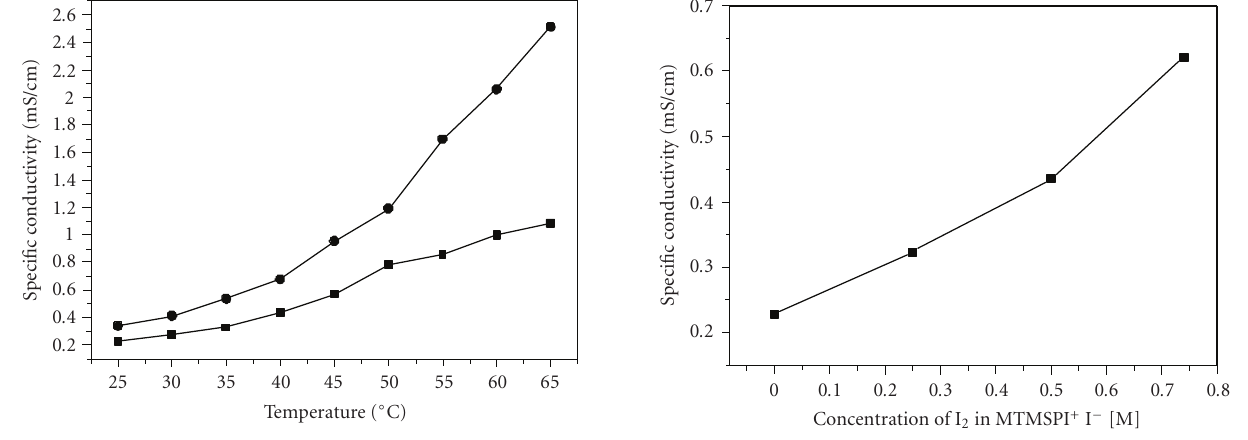
Figure 7: Influence of added iodine on the specific conductivity of nonhydrolyzed MTMSPI + I −